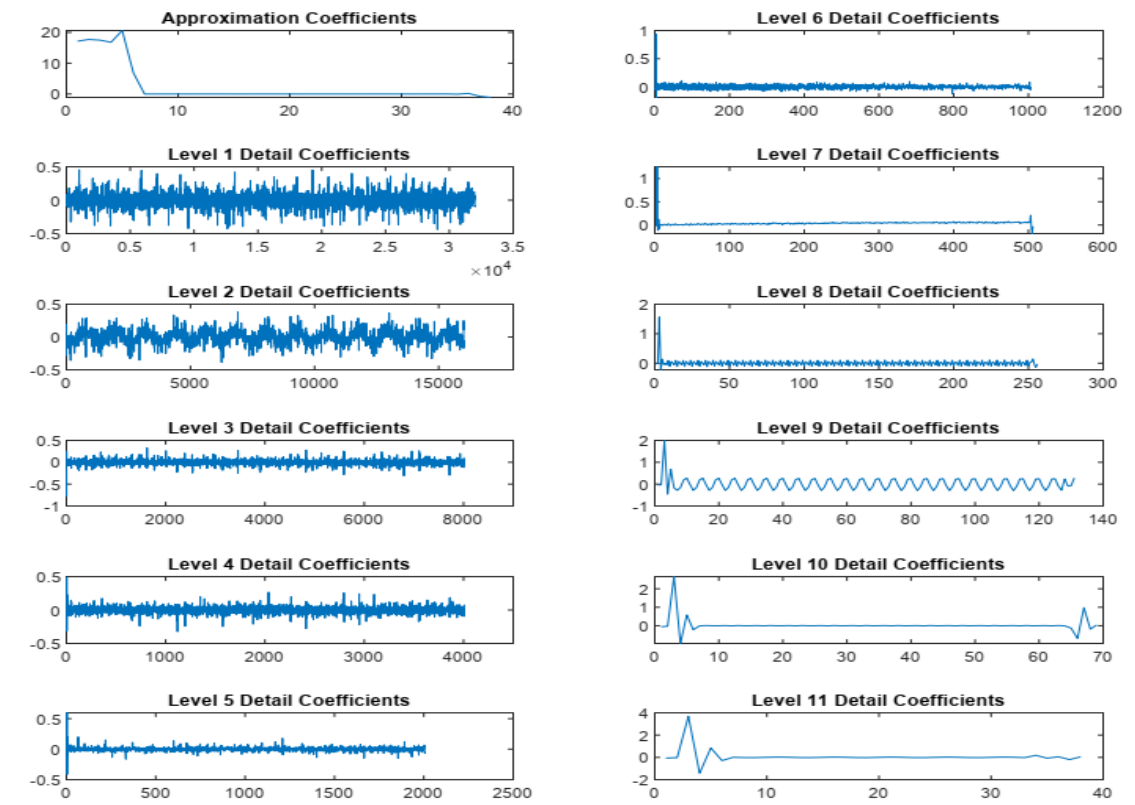
Figure 9. Wavelet decomposition of the ‘db4′ mother wavelet of the outer fault bearing.